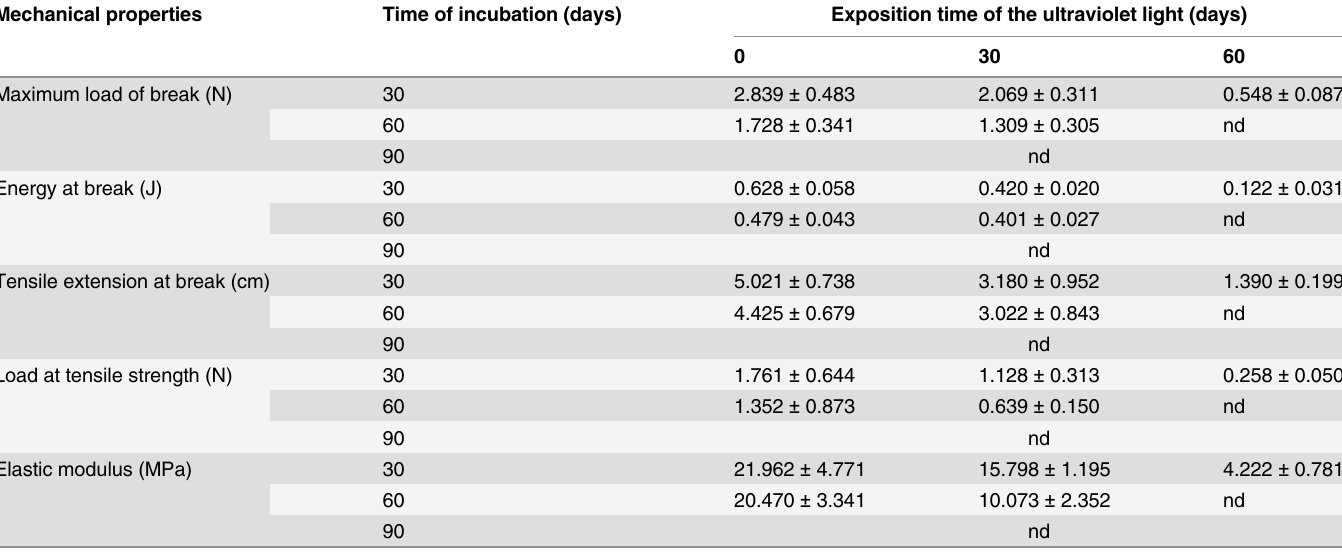
Table 3. Mechanical properties of green polyethylene exposure or not to sunlight after 30, 60 or 90 d of incubation with Pleurotus ostreatus